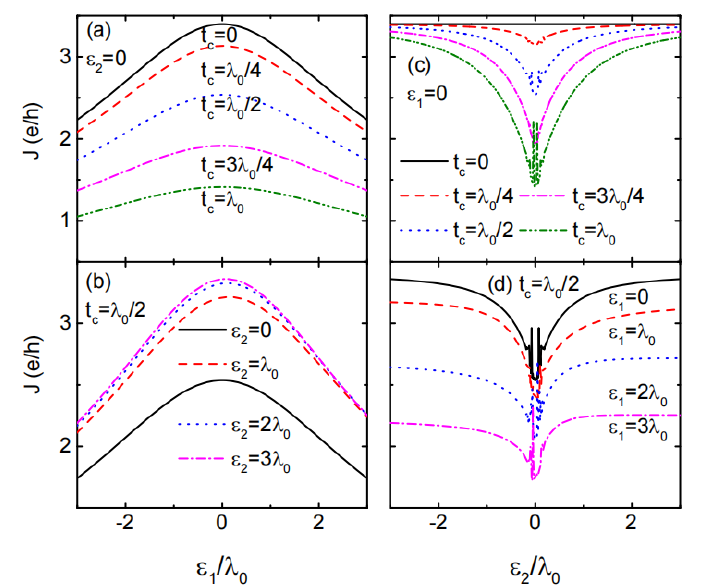
Figure 4. (Color online) Josephson current varying with respective to ε 1 in ( a ) for fixed ε 2 and different t c , and in ( b ) for fixed t c = λ 0 /2 and different ε 2 . Similar cases are shown in ( c , d ) for J − ε 2